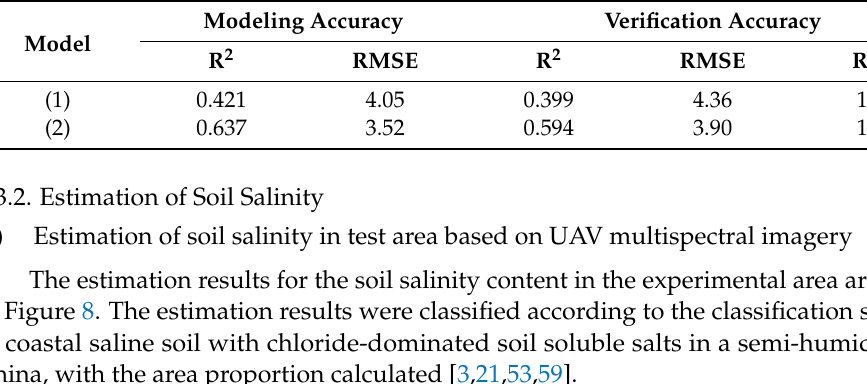
Table 9. Comparison of the accuracy of different models before and after reflectivity correction.